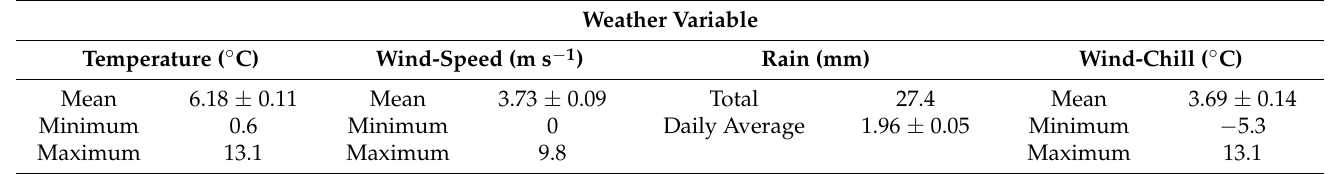
Table 2. Weather conditions (± standard error) at the experimental site during the study period (1 st to 14th of April 2019).